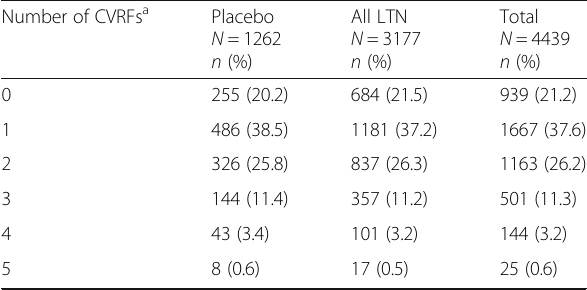
Table 2 Frequency of cardiovascular risk factors by dose regimen Number of CVRFs a